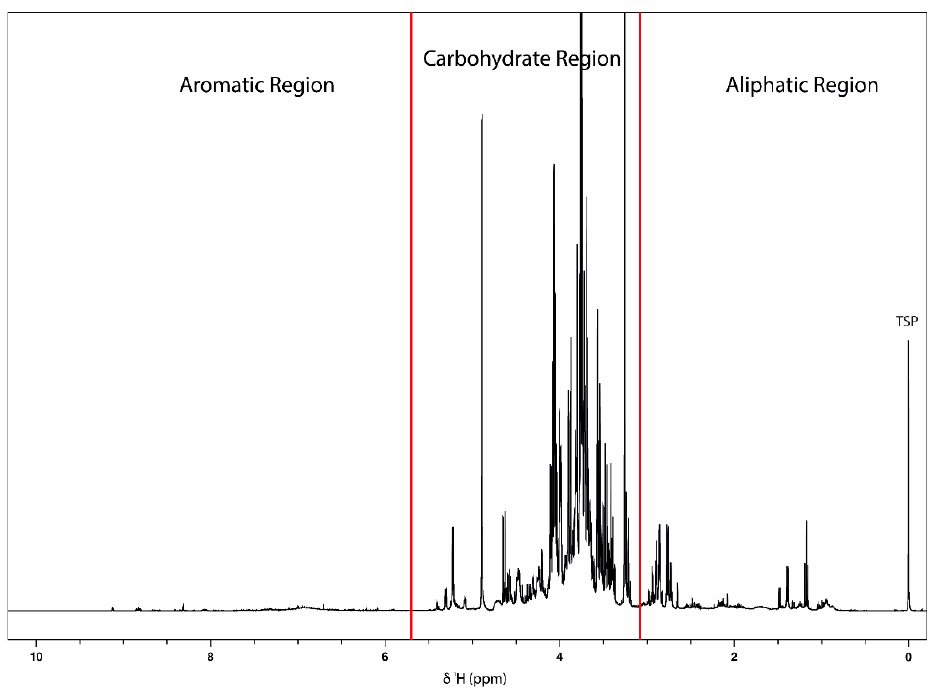
Figure 1. Representative 1D 1 H-NMR spectrum of a typical aqueous sample of acerola juice concen- trate (400 MHz, 300 K, D 2 O, pH 3.35, 20 mM TSP).